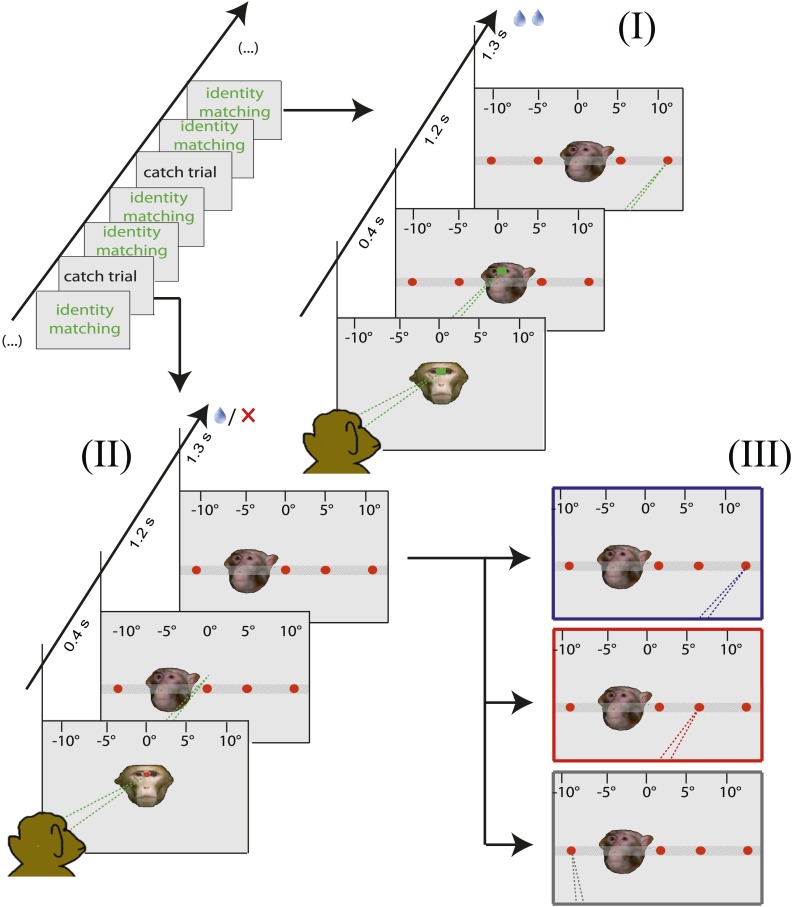
Design of the control experiments testing for learned associations between facial identity and the spatial position of the target.It was performed outside the MRI scanner in order to shed light on the strategies utilized to solve the identity matching task. The observer was confronted with a sequence of normal identity matching trials (I) with occasional catch trials (II, 6–12% share) in which the demonstrator portrait was shifted horizontally (shifts of −10°, −5°, 5° and 10° with respect to the default central position, the cartoon assumes −5° shift). In any case, the observer was asked to generate a saccade towards the target singled out by facial identity. In the case of ordinary identity matching trials the observer was rewarded contingent on the response. In the case of catch trials, a reward was granted on 50% of the catch trials, independent of the target chosen, provided the observer had stayed on the chosen target for at least 1 s. These responses were later classified into three strategy categories (III). (1) The 'learned absolute spatial associations' category (blue outline): target chosen according to its absolute spatial position associated with a given demonstrator facial identity, (invariant in space after demonstrator's portrait shift). (2) The 'learned relative spatial associations' category (red outline): target chosen according to its relative distance associated with a given demonstrator portrait's identity (now shifted horizontally together with the demonstrator portrait; the cartoon assumes a shift of the target from 10° to 5°). (3) The 'other' category (gray outline). Dashed lines in the figures indicate the observer's eye gaze.